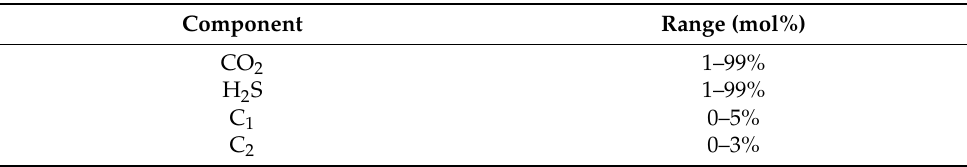
Table 1. Range of acid gas mixture components